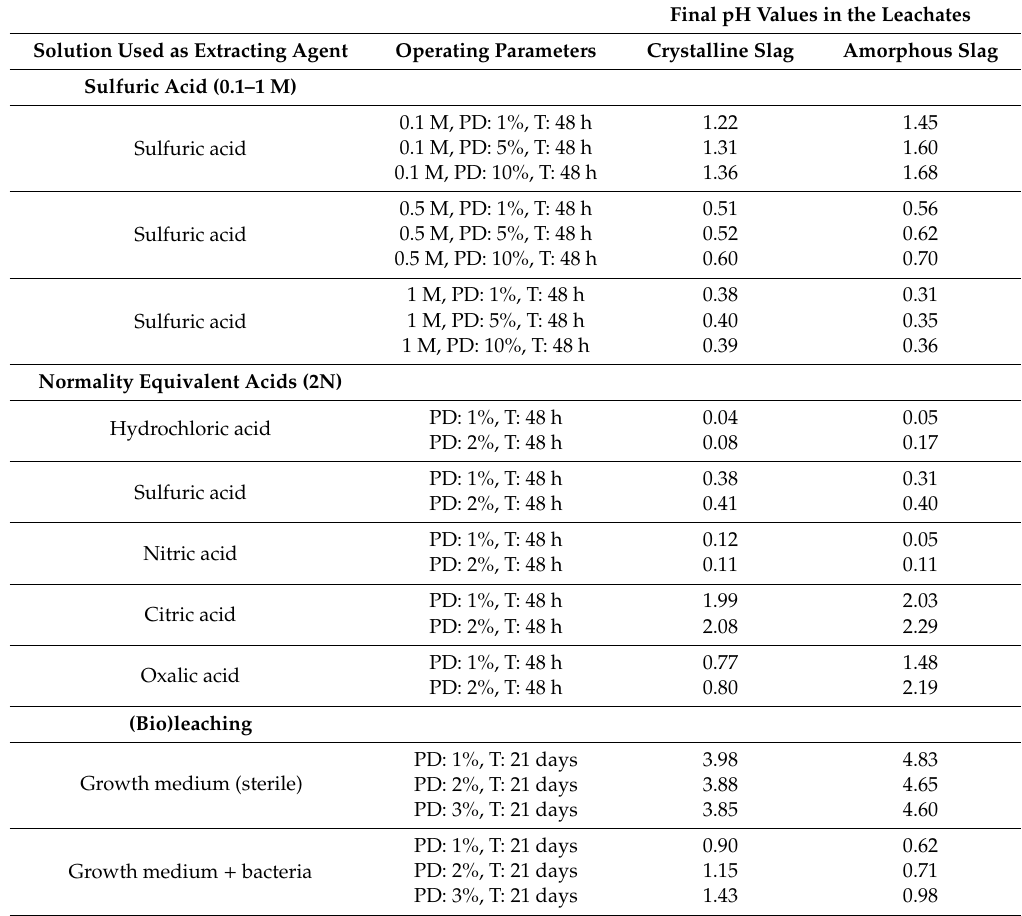
Table 2. The final pH values in the leachates from executed